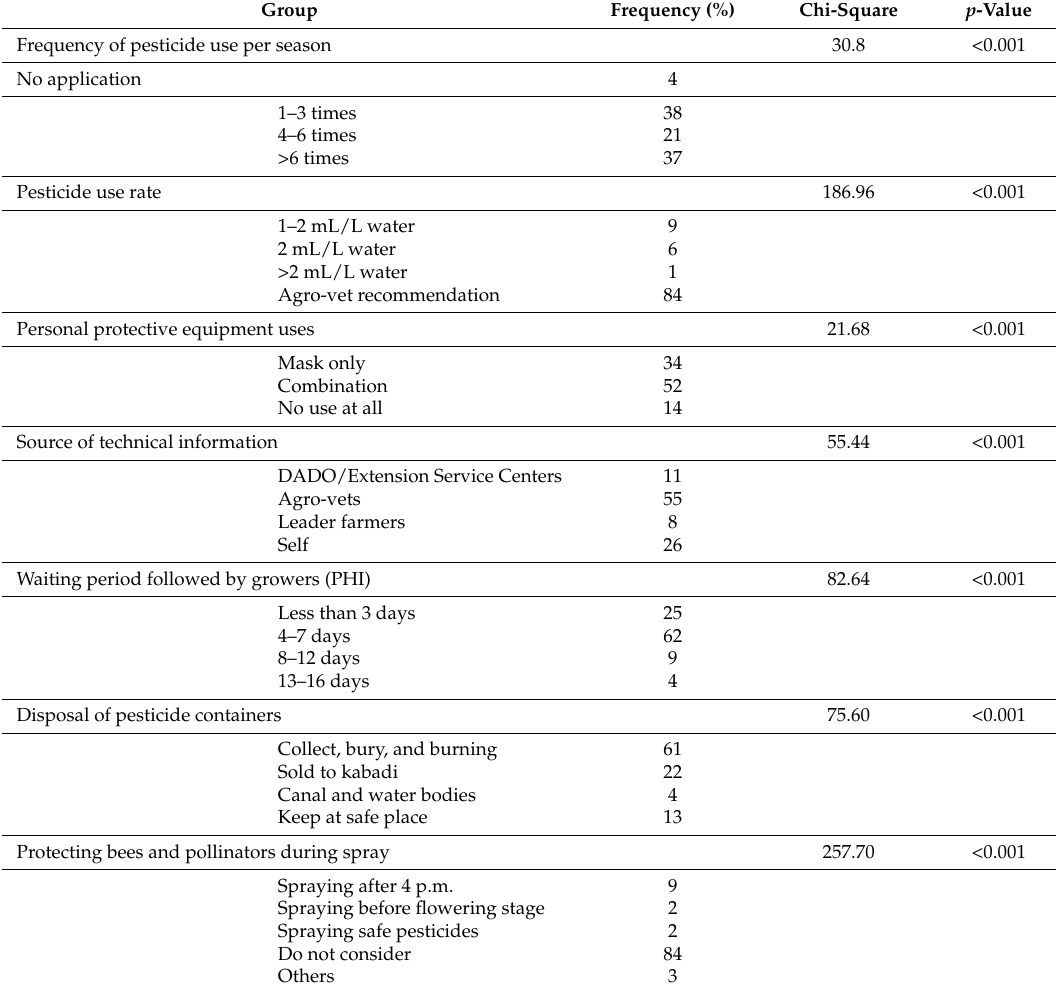
Table 3. Pesticide use patterns among vegetable growers in Chitwan, Nepal. Group